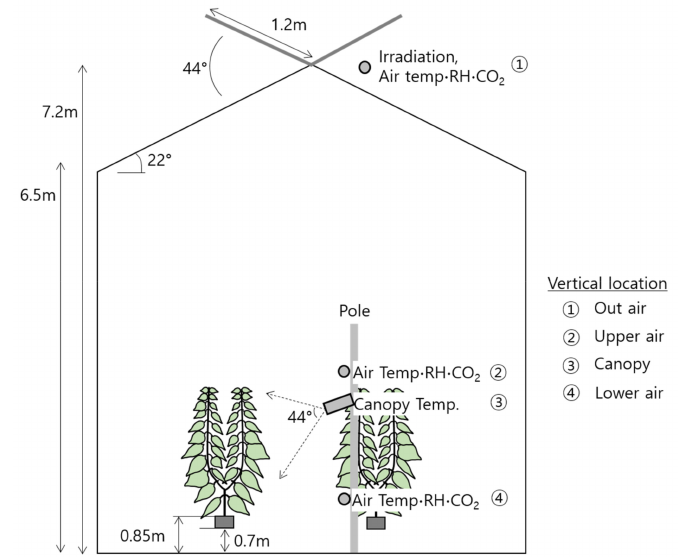
Figure 7. Schematic illustrating the sensor installation elevation. The view of the angle of the infrared sensor to measure the surface temperature of the canopy was installed to match the height of the canopy, and the temperature and humidity sensors were located to measure the top and bottom of the canopy with LAI 2.5. Due to the characteristics of the crop rows in the greenhouse, the infrared sensor was installed in the row opposite the other